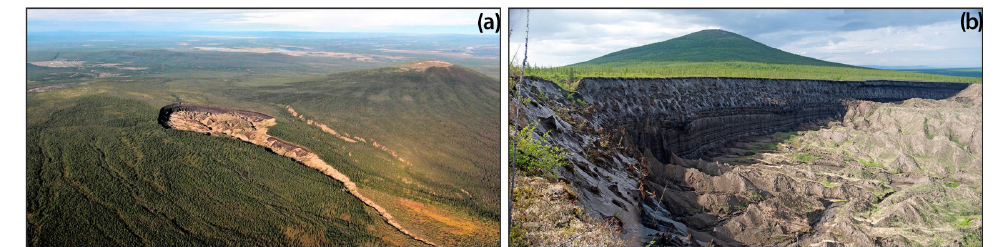
Figure 2. General views of the Batagay mega-slump. (a) From aircraft (L. Vdovina, Yana Geological Service, 17 August 2011). (b) The exposure at its deepest incision was photographed from the southern edge of the cirque (19 June 2014). For orientation, note Mt. Kirgillyakh in the upper right (a) or in the background (b)